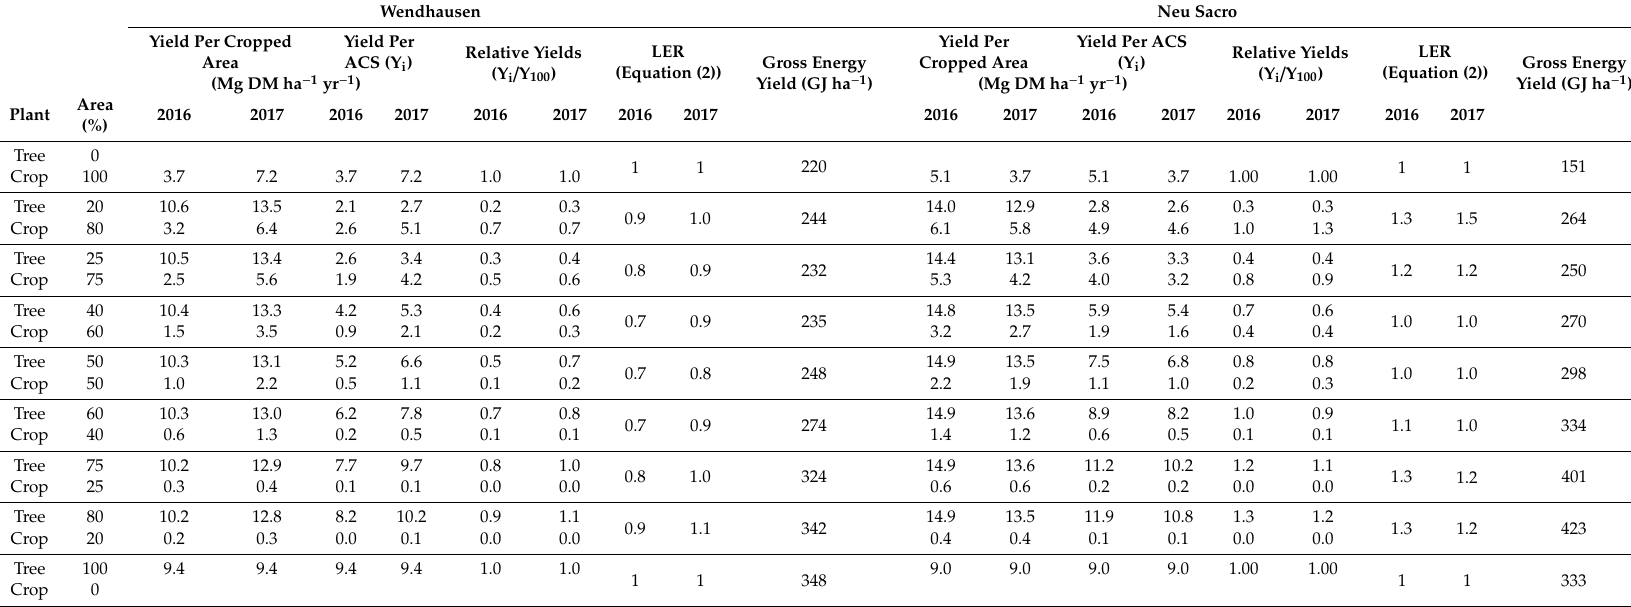
Table A4. Tree and crop yields per cropped area and per alley-cropping system, their corresponding relative yields, the inferred LER and gross energy yield values, as projected by the Yield-SAFE model at Wendhausen and Neu Sacro in 2016 and 2017 and under di ff erent ratios of tree area to crop area. Wendhausen Neu